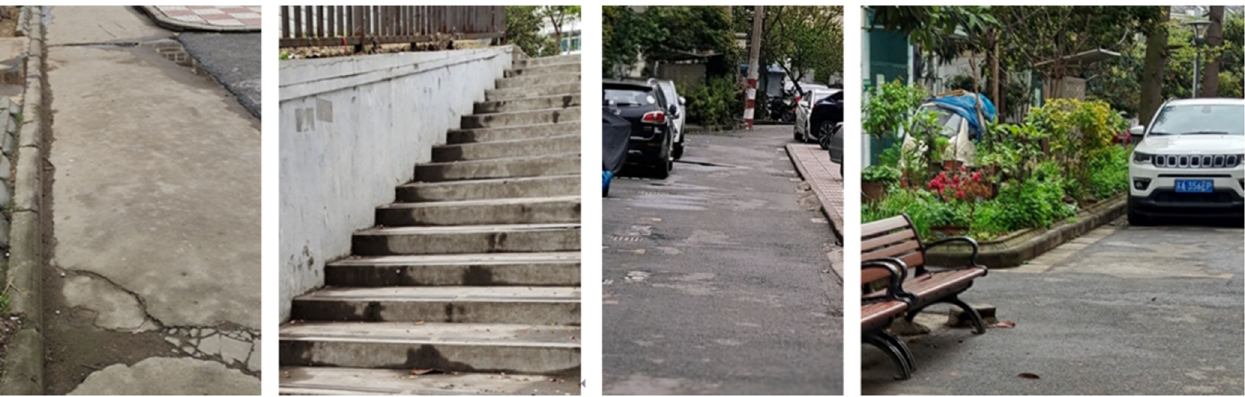
Figure 8. Road conditions (photographed by Yuxin Xu in 2022).